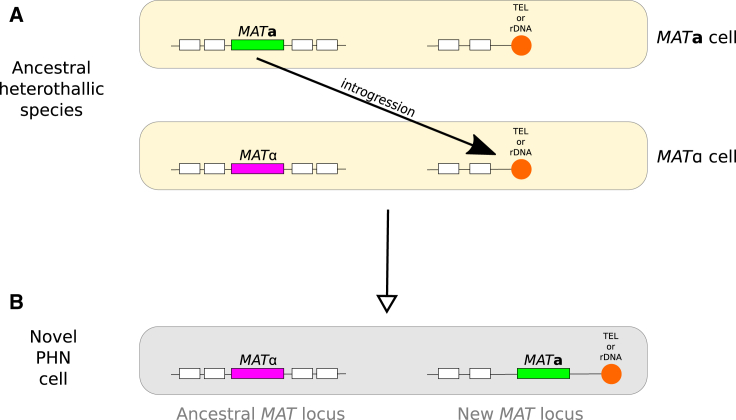
Proposed Mechanism of Transition from Heterothallism to Non-contiguous Primary Homothallism (PHN) by IntrogressionWhite boxes at each locus represent genes syntenic among all three cells, directly below one another.(A) Two haploid cells of the ancestral heterothallic species. A DNA introgression event transfers or copies the single MAT locus of one cell into another cell of the opposite mating type, possibly via a cycle of mating, genomic rearrangement and sporulation. The introgressed DNA is integrated into the recipient genome, either close to a telomere (as observed in the genus Nadsonia) or close to an rDNA array (as observed in the genus Peterozyma), marked in orange.(B) The resulting haploid cell has two MAT loci in a PHN arrangement.